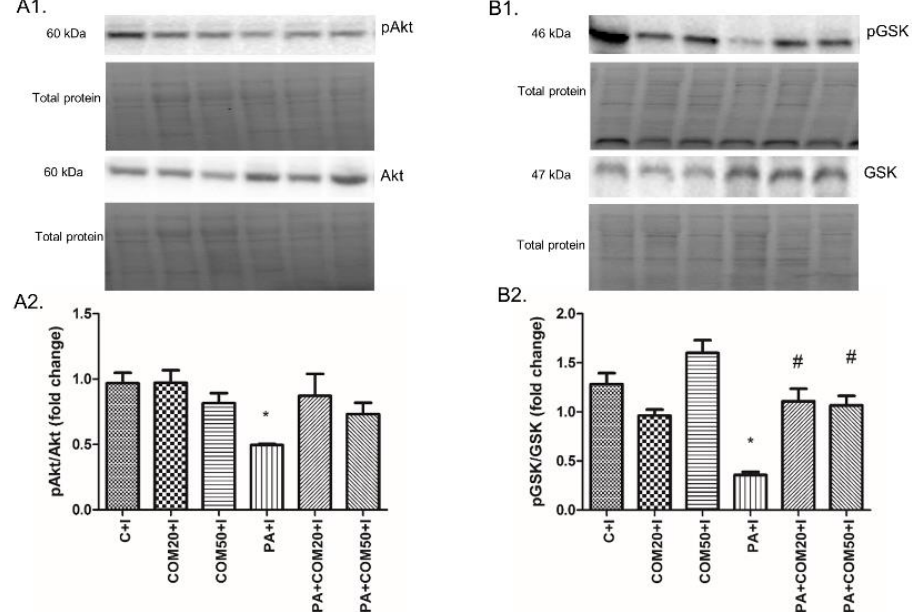
Figure 2. Representative Western blot membranes of evaluated proteins, i.e., pAkt/Akt—phosphorylated protein kinase B/protein kinase B ( A1 ), pGSK-3 β /GSK-3 β —phosphorylated glycogen synthase kinase 3 β /glycogen synthase kinase 3 β ( B1 ), and the corresponding images of total protein staining after membrane transfer used for normalization. The expression of proteins involved in insulin signaling pathway, i.e., pAkt/Akt ( A2 ), pGSK-3 β /GSK-3 β ( B2 ) in primary rat hepatocytes. The cells were incubated with presence or absence of PA (0.5 mM) or/and COM (20 or 50 µ M). Additionally, every group was also incubated with insulin, as it was described in Materials and Methods section. The expression of the proteins was evaluated by the Western blot technique. The data are shown as the mean ± SD and are based on six independent determinations ( n = 6); * p < 0.05 significant difference vs. control + insulin group; # p < 0.05 significant difference